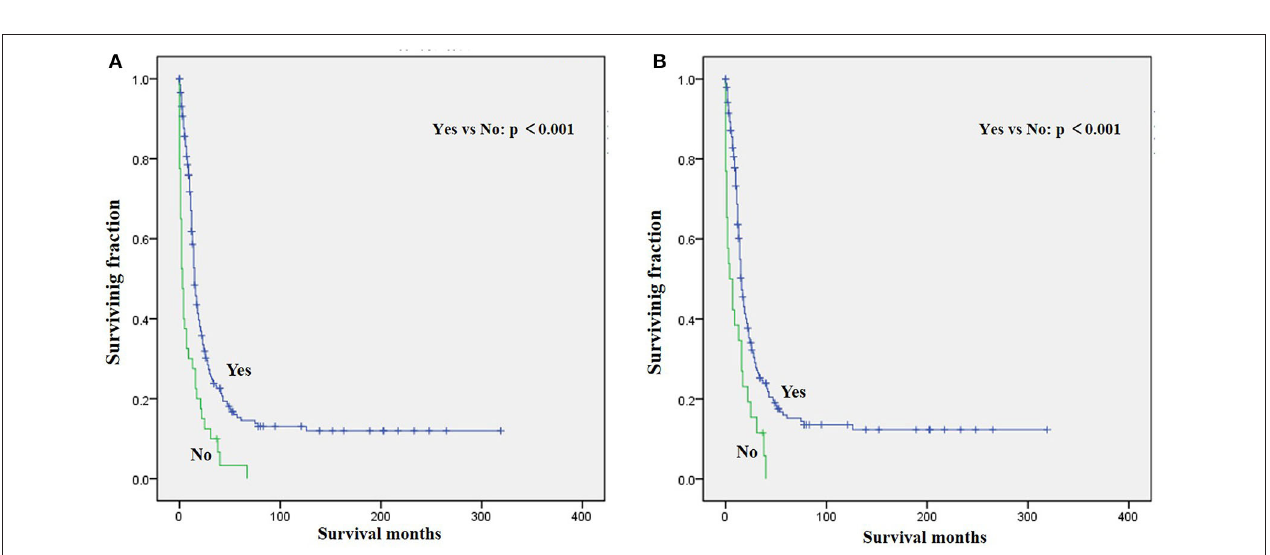
FIGURE 2 | Graphs show Kaplan–Meier curves of (A) OS and (B) CSS in patients with LRMS and metastasis at diagnosis stratified by